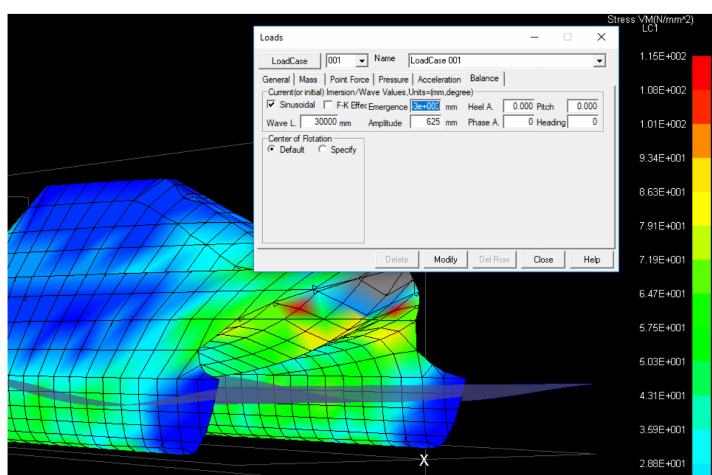
Figure 6. Applied wave specifications to FEA